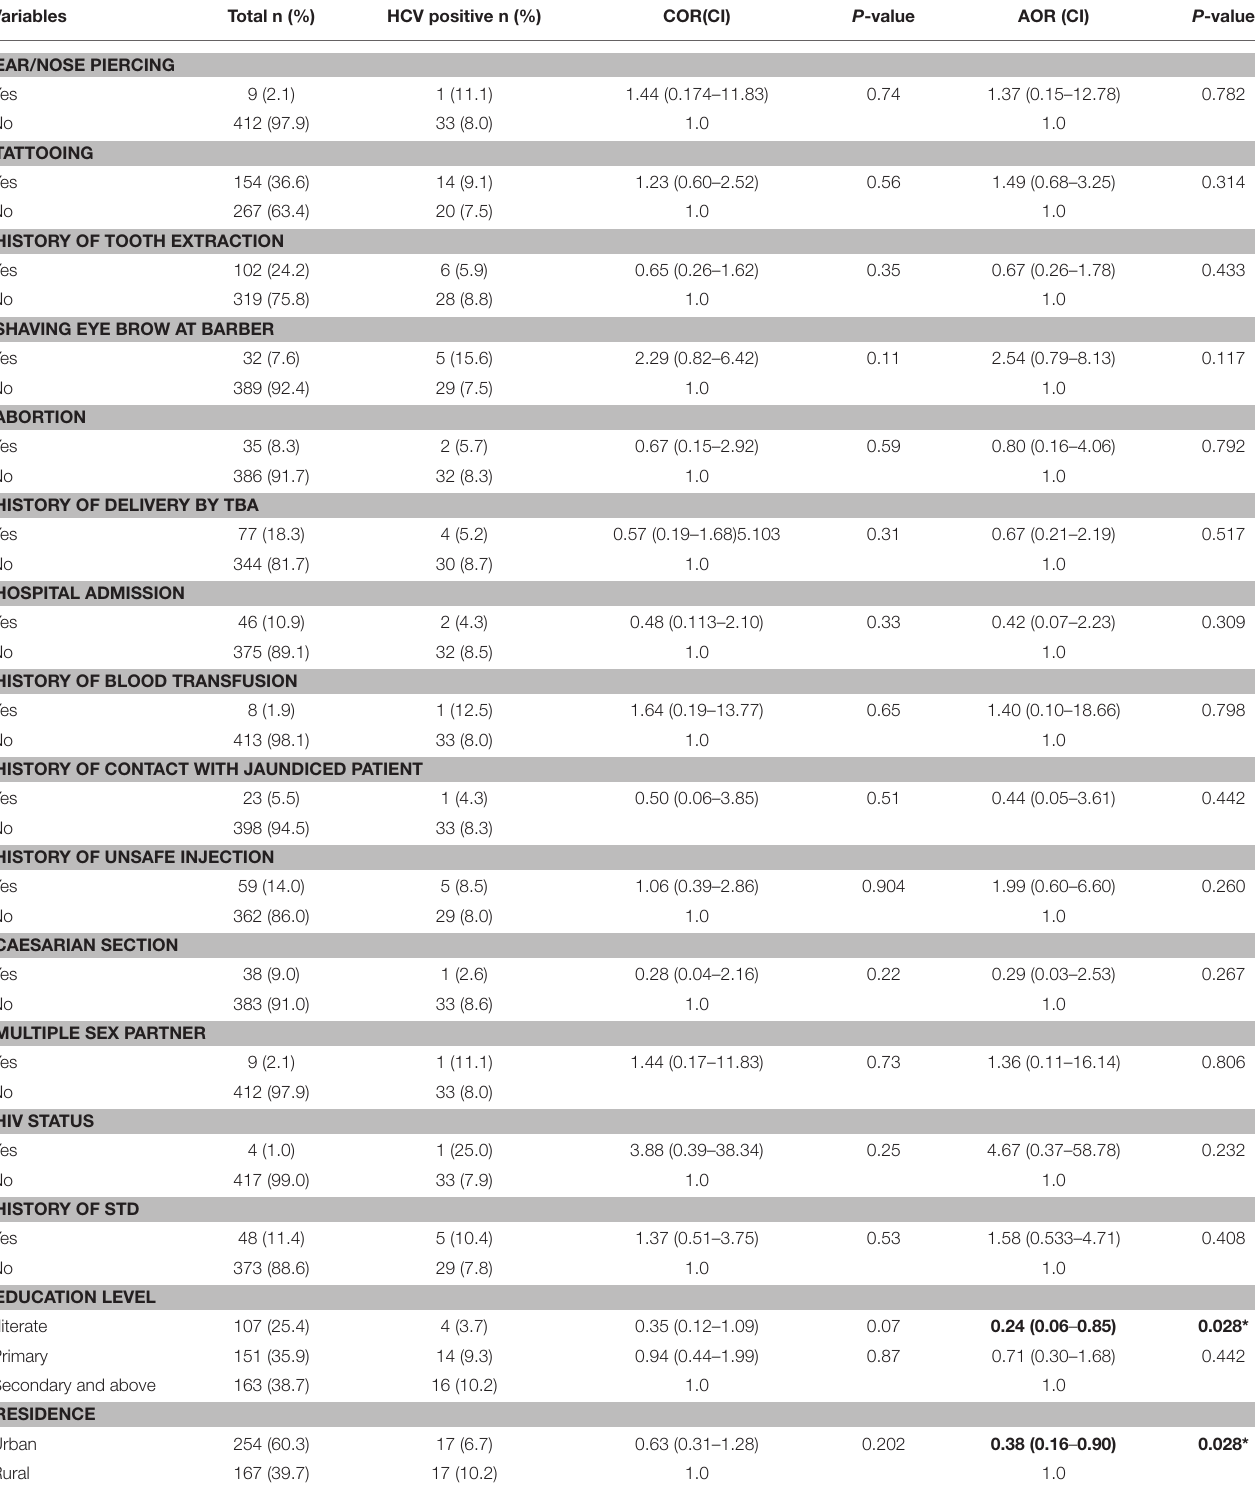
TABLE 2 | Factor associated with HCV positivity among pregnant women attending antenatal care at East Wollega Administrative Zones, Ethiopian, 2014 ( n = 421).